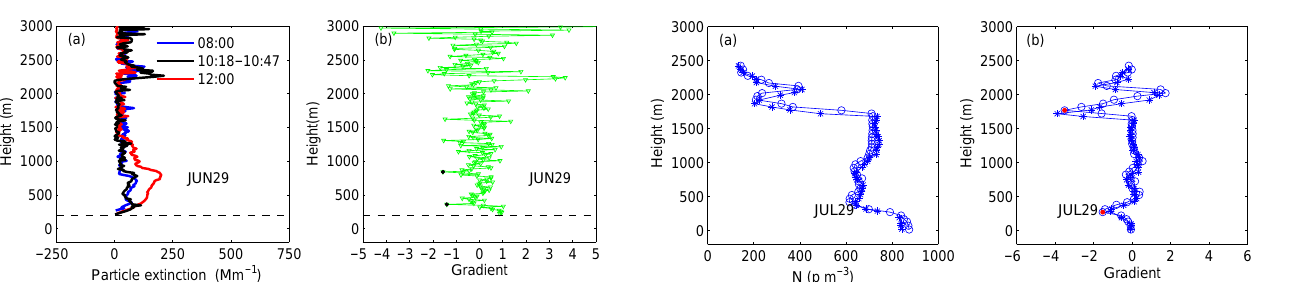
Figure 5. Vertical profiles of aerosol number concentration (a) and their gradients (b) from the ascent (open circles) and descent (aster- isks) flight in the early morning of 29 July (flight 4). The red solid circles indicate the tops of the mixed layer and the residual